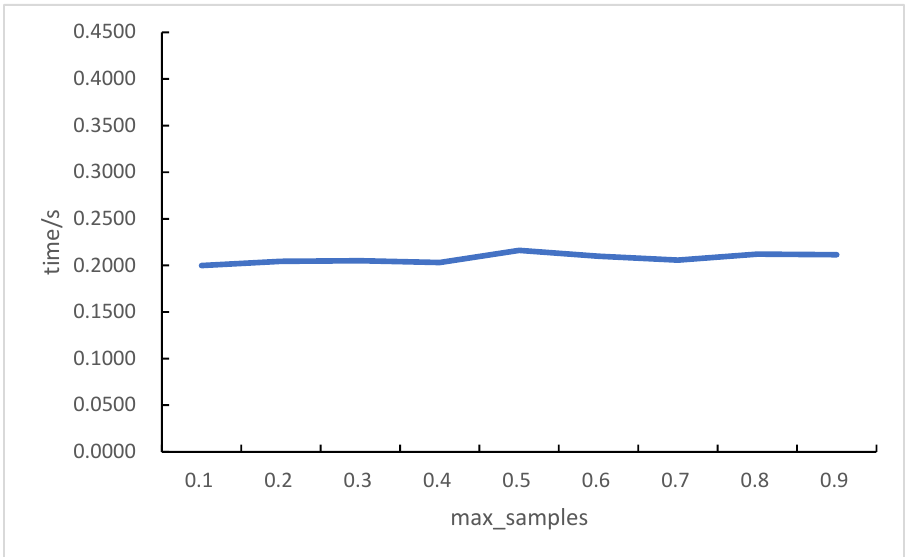
Figure 14. max_samples optimizes predict_time.